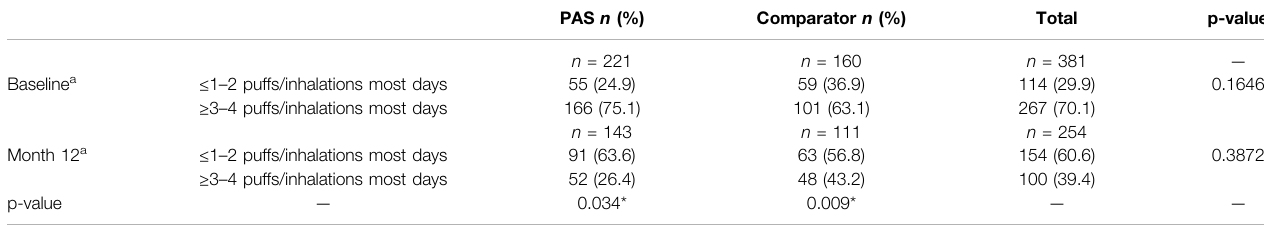
TABLE 3 | Patient reliever